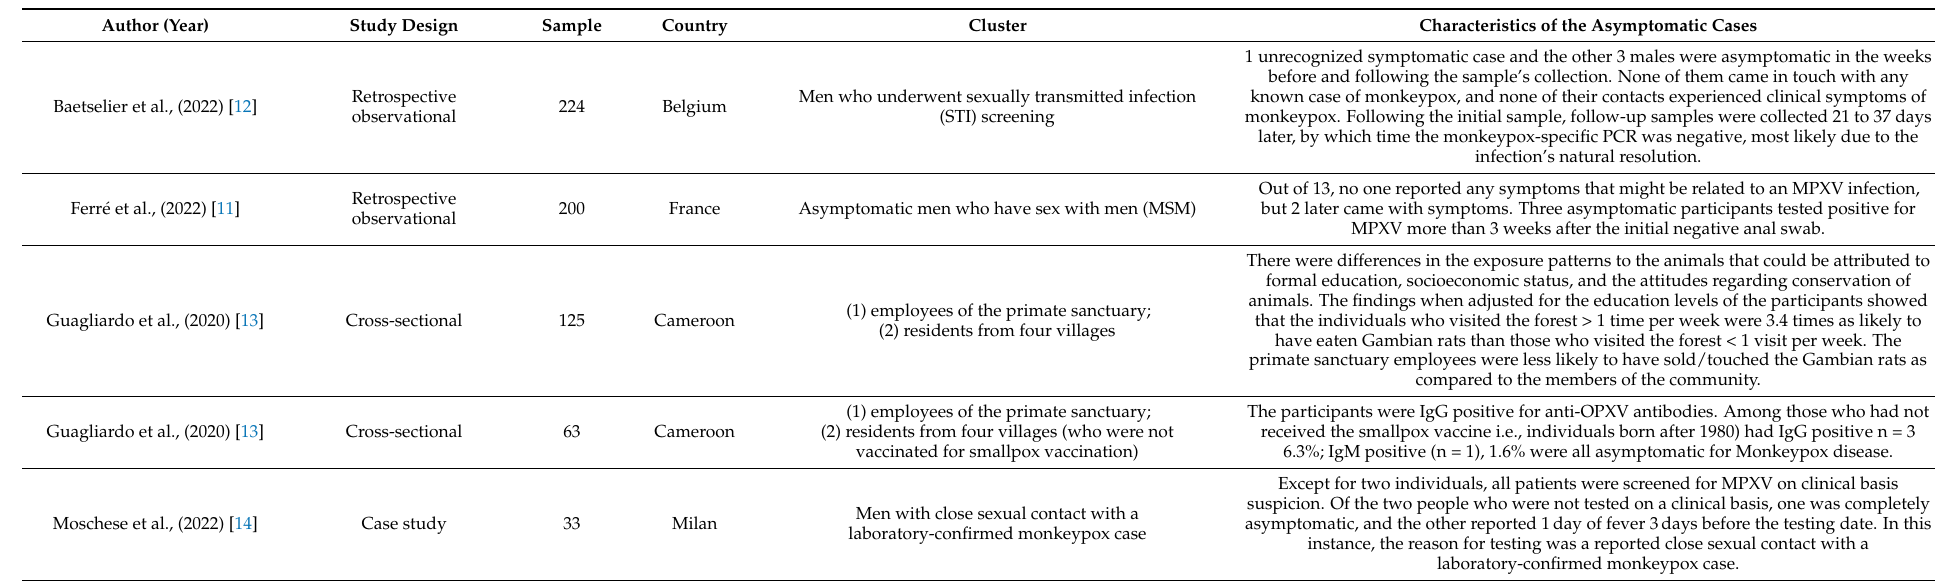
Table 1. Summary of Studies Included in